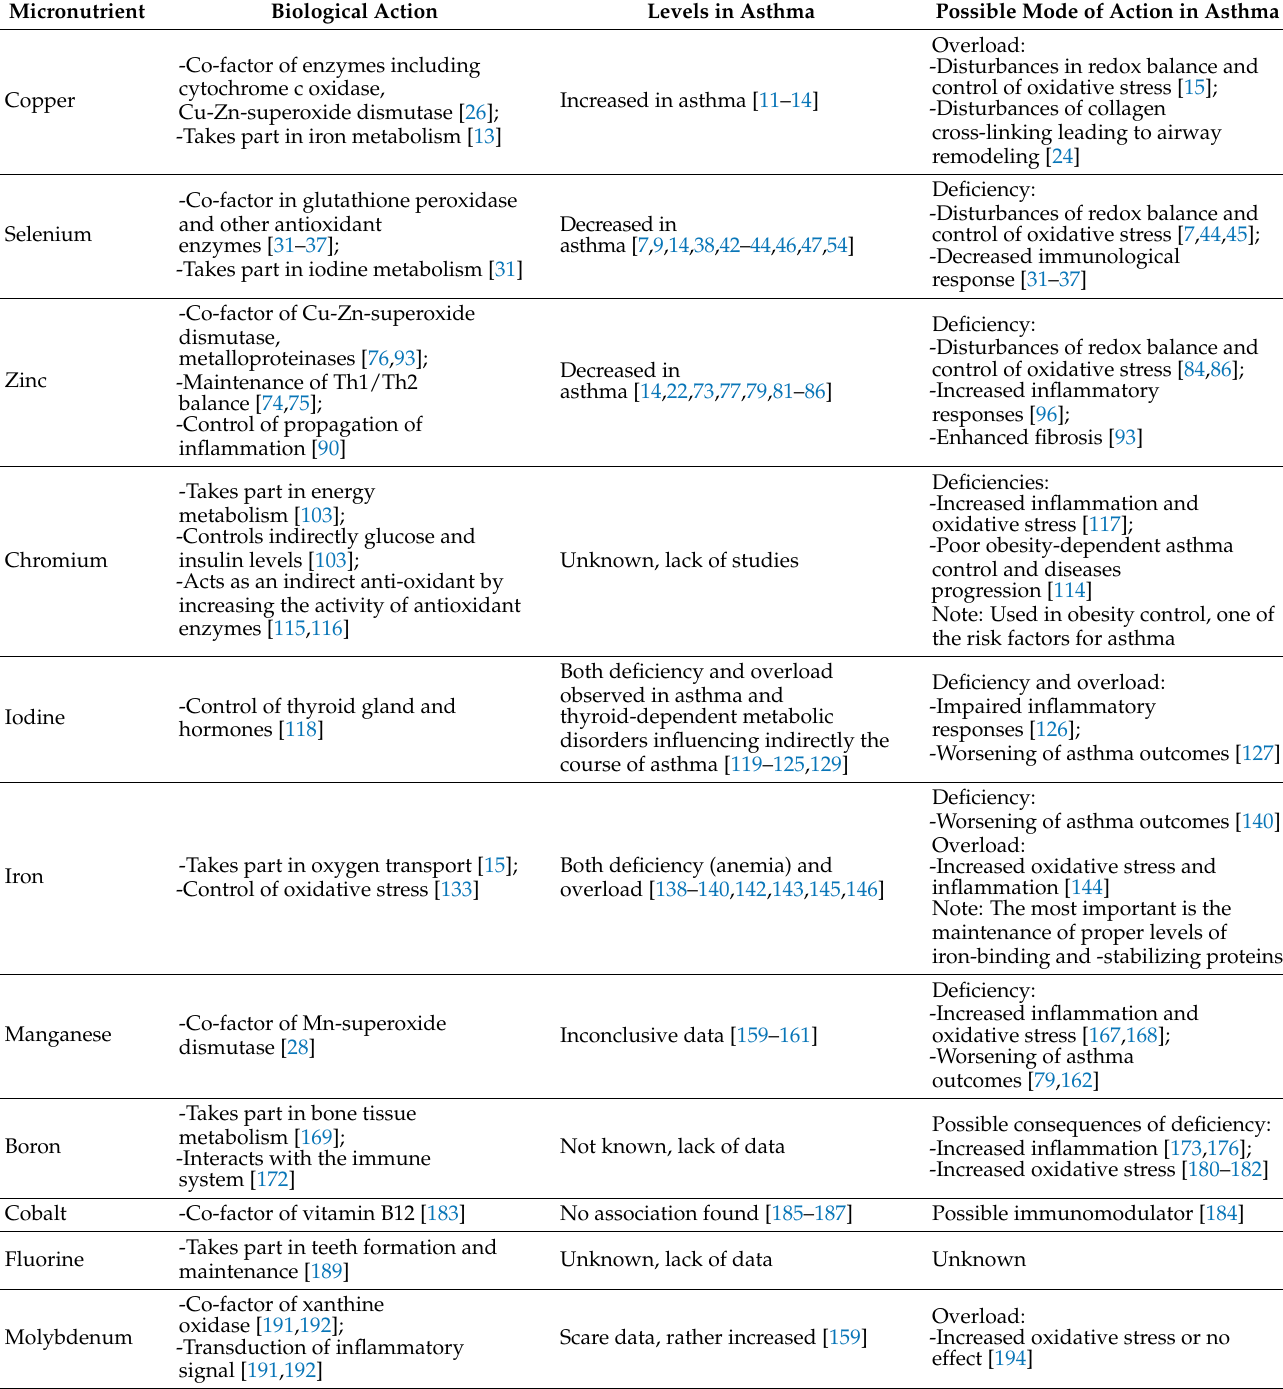
Table 1. Summary of the role of micronutrients and their disturbances in